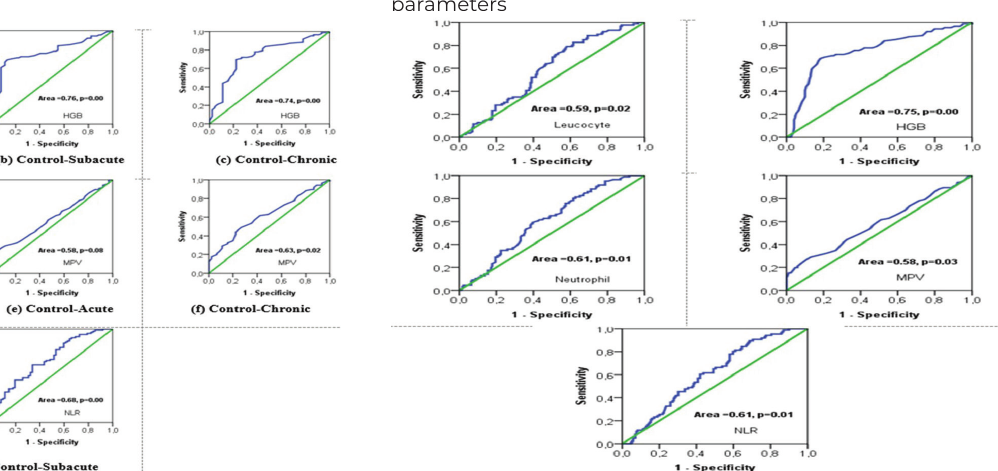
Figure 1 - The results of ROC analysis between the brucellosis subgroups and the control group for the significant hematological parameters